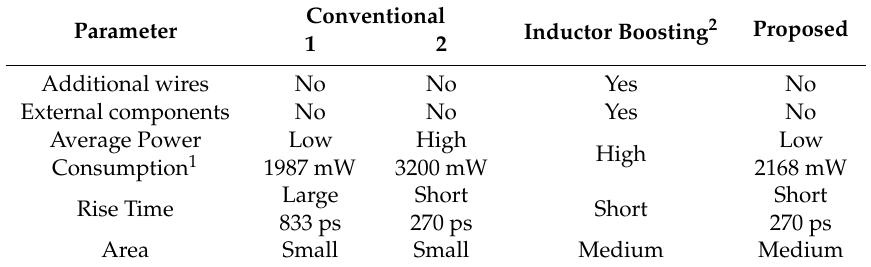
Table 1. Comparison of the existing techniques with the proposed negative voltage boosting.